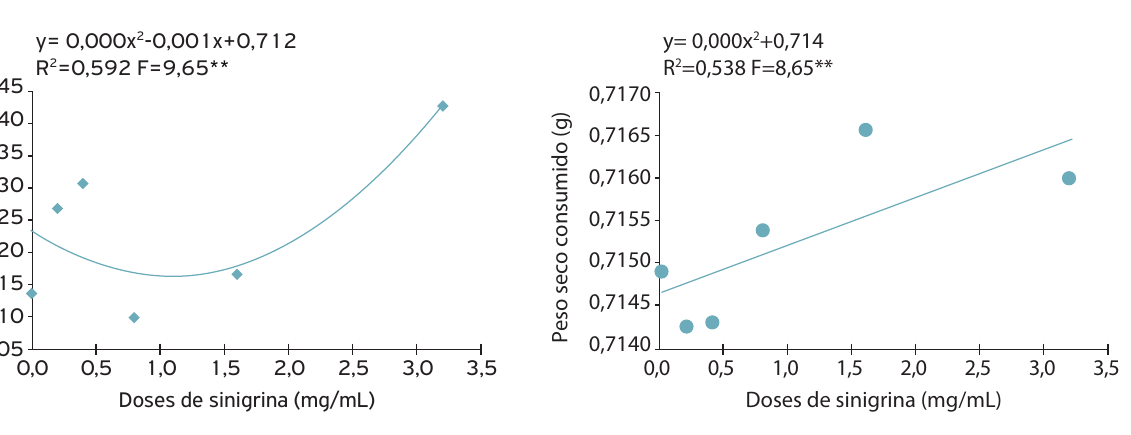
Figura 5. Curva ajustada para regressão polinomial entre o peso seco consumido de folhas de couve por lagartas de Plutella xylostella e doses de sinigrina .